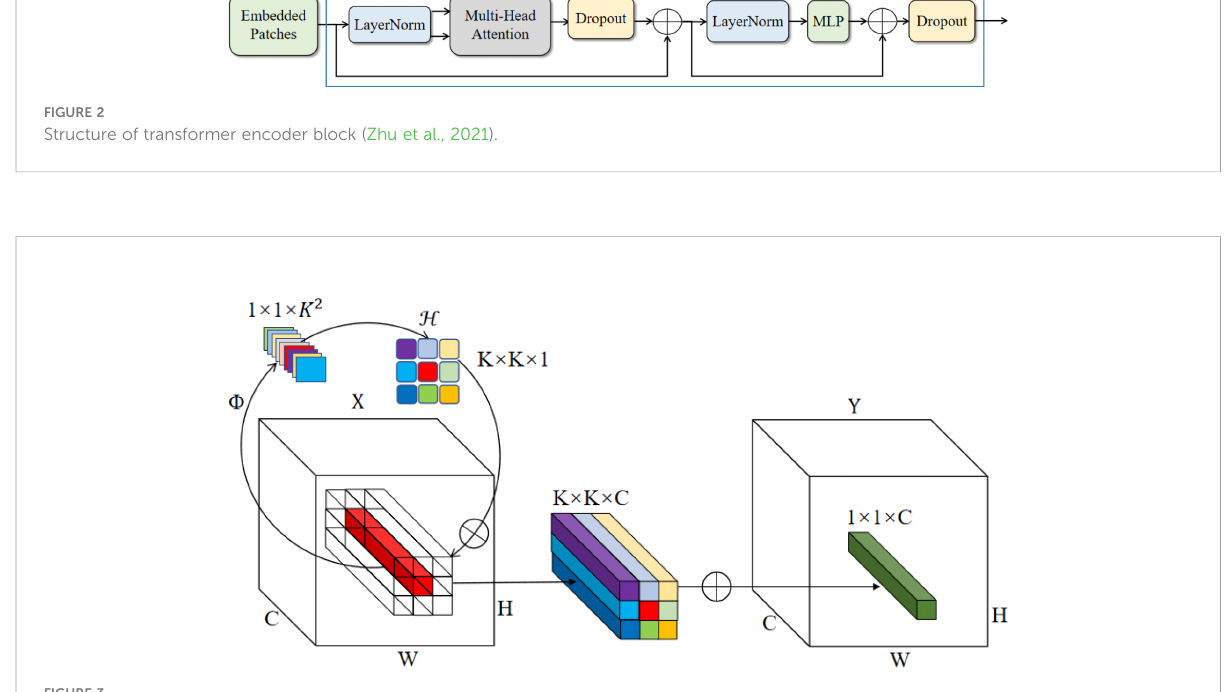
FIGURE 3 Schematic illustration of involution (Li et al.,